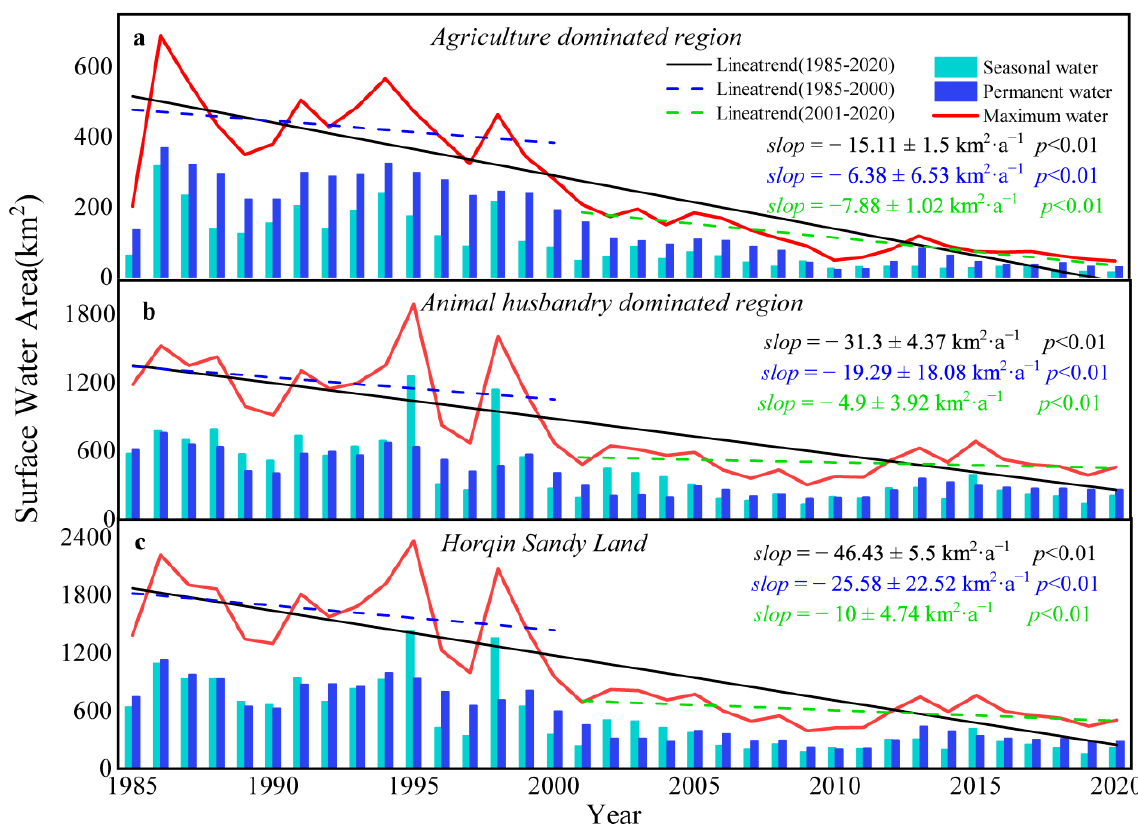
Figure 6. Time series of SWA (maximum, seasonal, and permanent water) changes from 1985 to 2020 in ( a ) ADR, ( b ) AHDR, ( c ) HQSL.